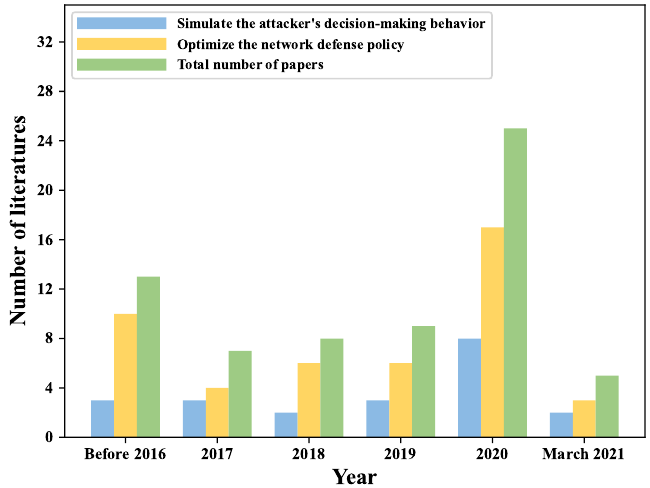
Figure 1. Research trend of cyber defense decision-making based on reinforcement